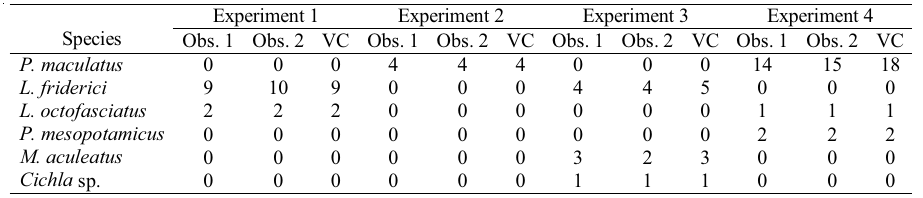
Table 1. Species and number of individual observed in each experiment for two on site human observers (Obs.) and one video count